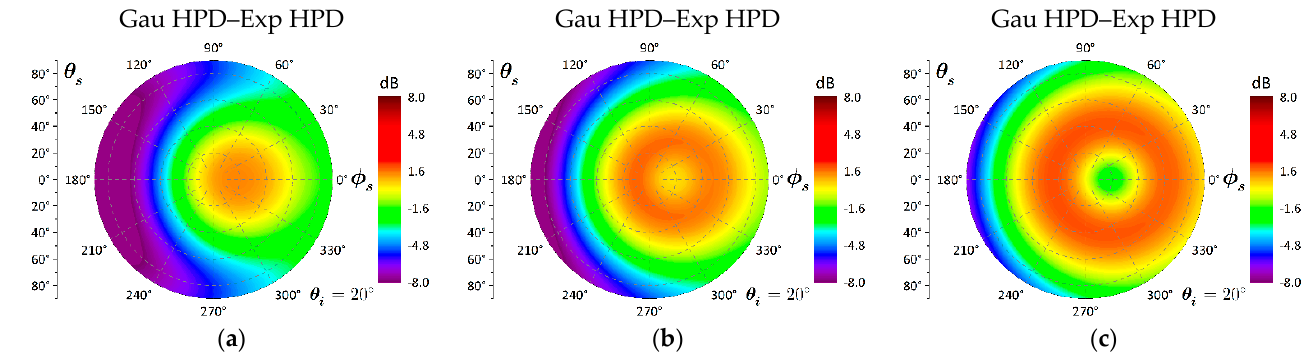
Figure 10. Difference of bistatic scattering between Gaussian and exponential HPD rough surface with Gaussian PSD kl = 8, k σ = 0.5,1.0,1.5, ε r = 15 − j 1.5, θ i = 20. ( a ) k σ = 0.5, ( b ) k σ = 1.0, ( c ) k σ =